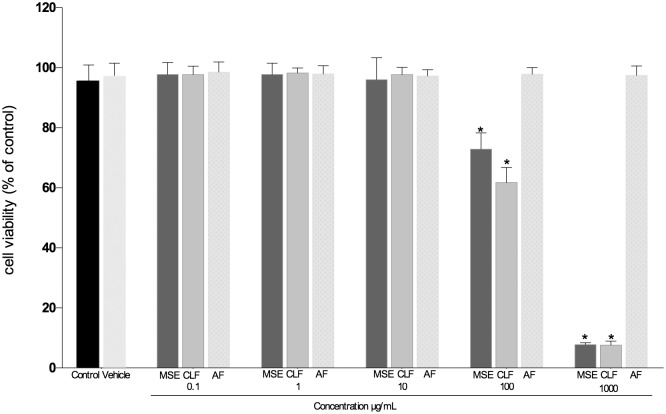
Cytotoxicity test.Cytotoxic effect of MSE, CLF and AF on fibroblasts HGF-1 cells. Data are expressed as mean ± SEM using one-way analysis of variance (ANOVA) followed by Dunnet’s multiple comparison tests as compared to non-treated. The level of statistical significance was set at 0.05.